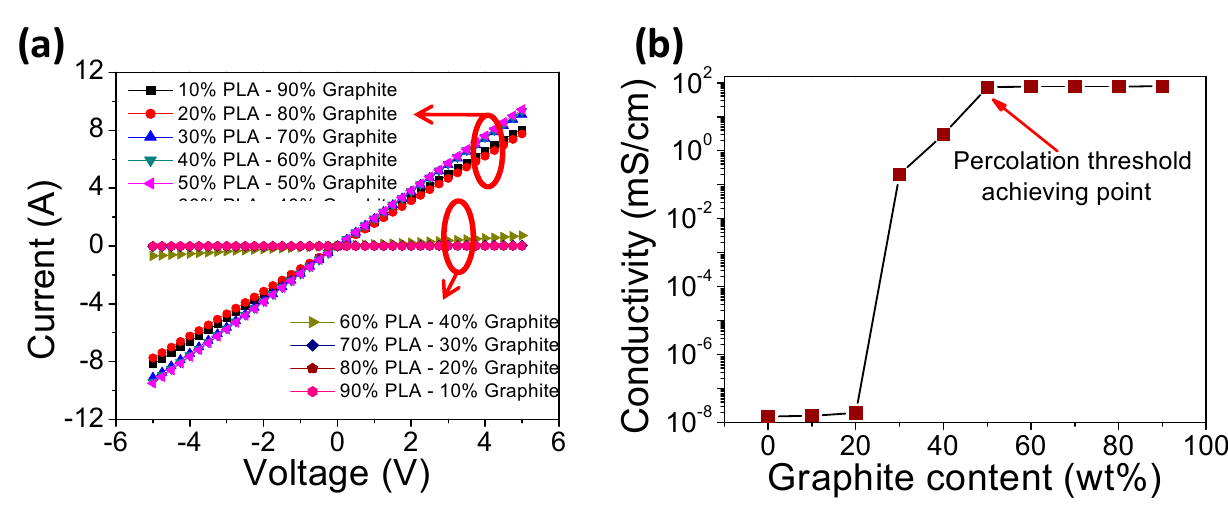
Figure 2. ( a ) I-V plots of Polylactic acid-Graphite composites with nine different compositions, ( b ) Effect of the graphite content on the bulk conductivity of PLA-graphite composite chips. Table 1. Bulk conductivity of different compositions of PLA-Graphite composite. Sr.